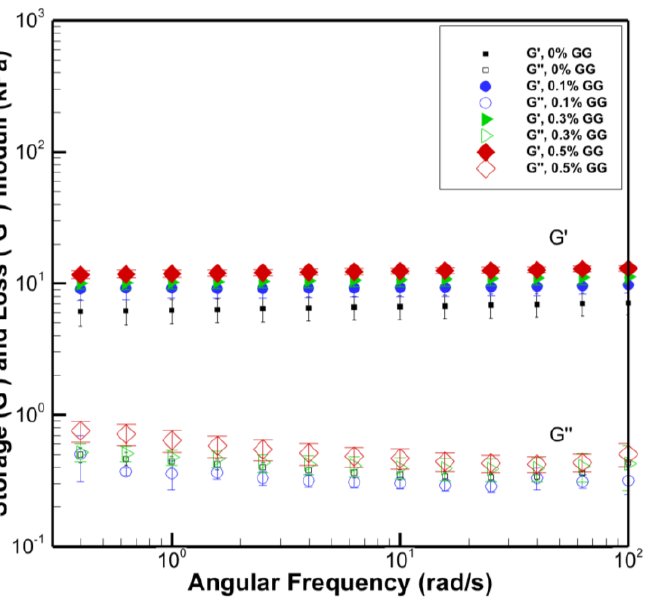
Figure 2. Storage modulus G ′ and loss modulus G ″ for pure PVA and PVA/GG hydrogels with different GG contents.